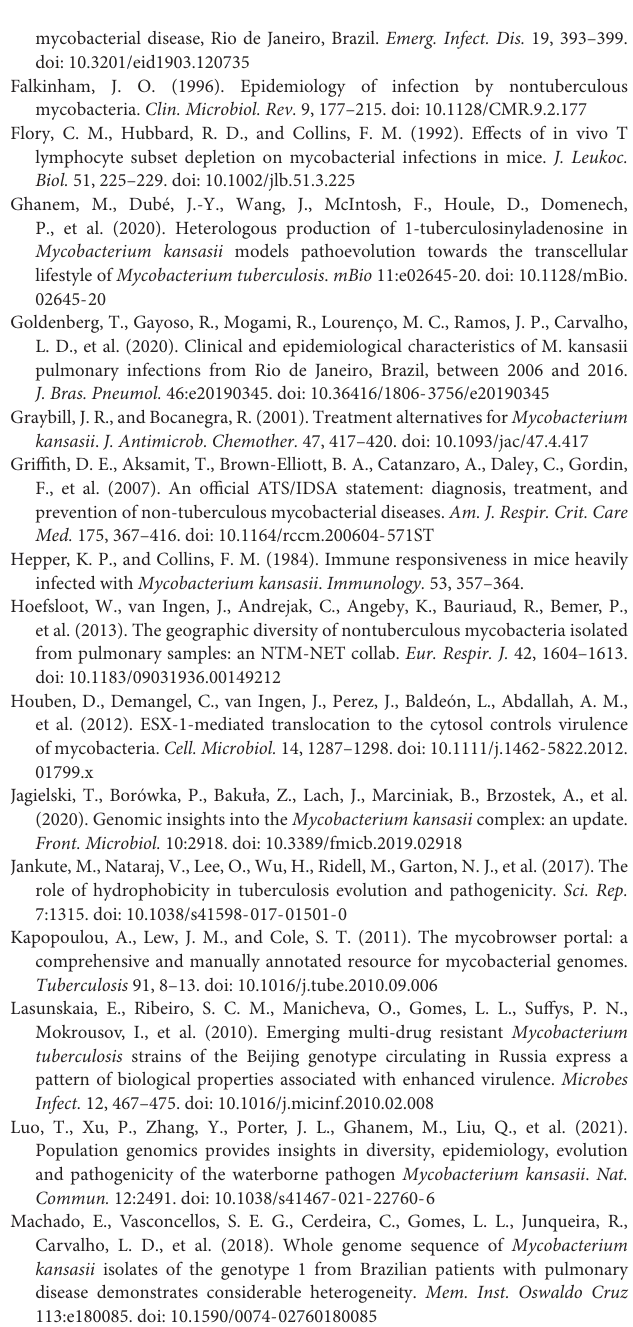
Supplementary Table 1 | Relative virulence of Mycobacterium kansasii clinical isolates in comparison with the reference ATCC strain 12478 evaluated in the in vitro model of infected macrophages and in the in vivo model of C57BL/6 mice infection. Supplementary Table 3 | Single nucleotide polymorphisms in virulence factors genes identified in 12 Mycobacterium kansasii strains compared to the reference strain Mycobacterium kansasii ATCC